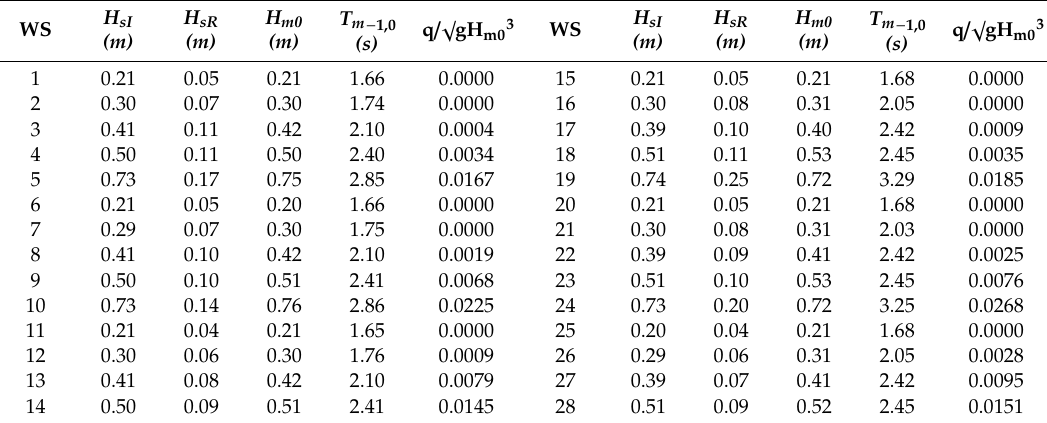
Table 5. Test results for cross-section type